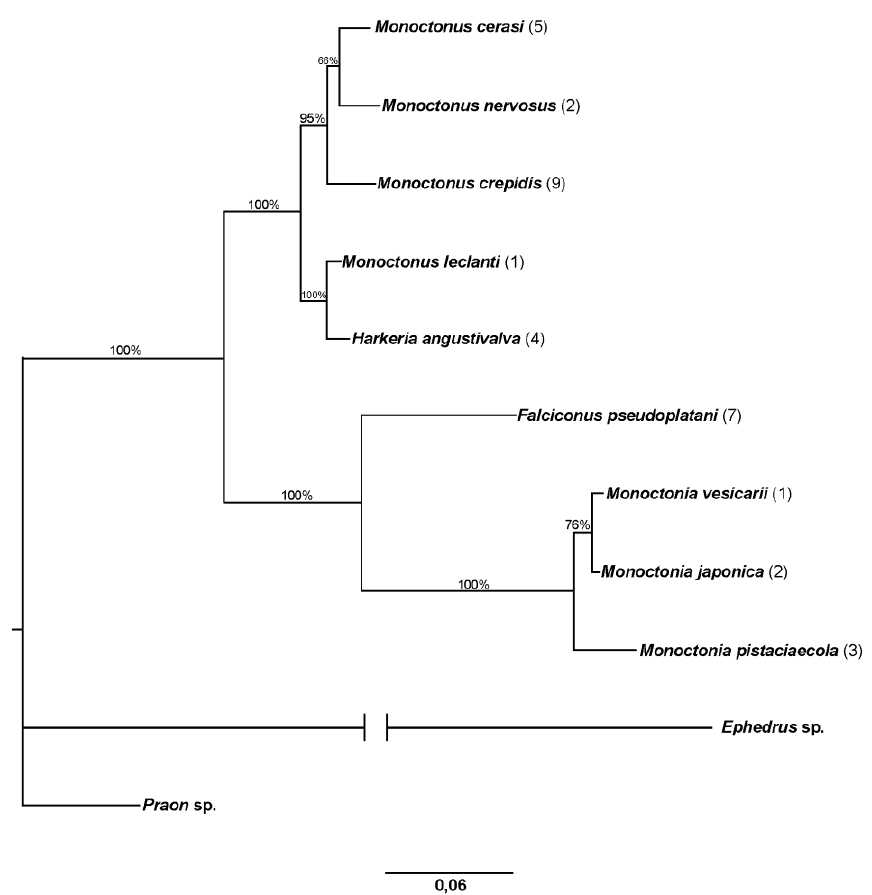
Figure 5. Phylogenetic tree based on 28S rDNA . The number of specimens of each species is shown in parentheses. Bayesian posterior probabilities are shown above branches.